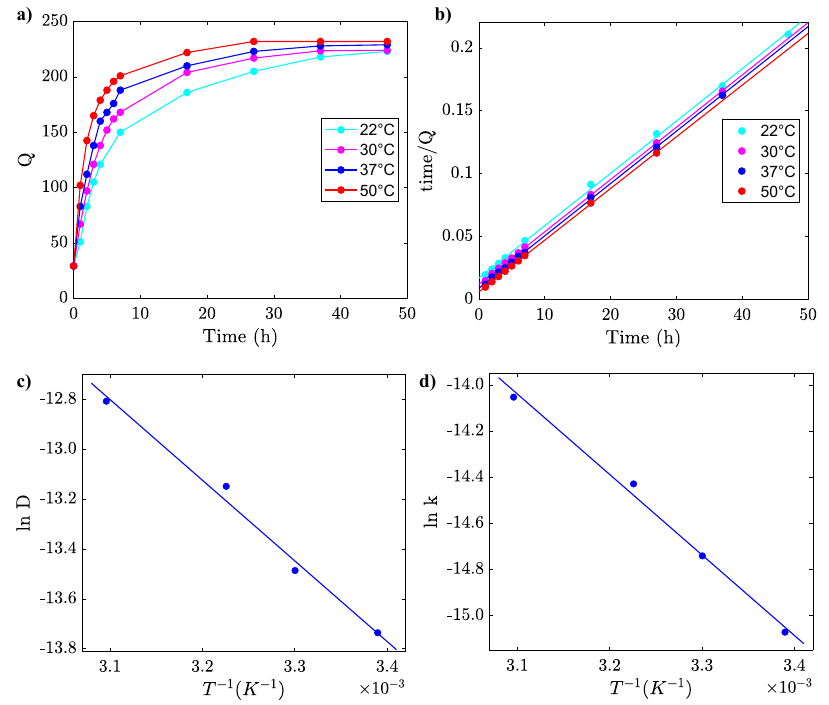
Figure 5. ( a ) Degree of swelling Q versus time t at various temperatures T . Circles: experimental data, solid lines: guides for eye. ( b ) Fitting of the data by Equation (3). ( c , d ) Coefficients D and k versus temperature T . Circles: treatment of observations, solid lines: approximation of the data by Equation